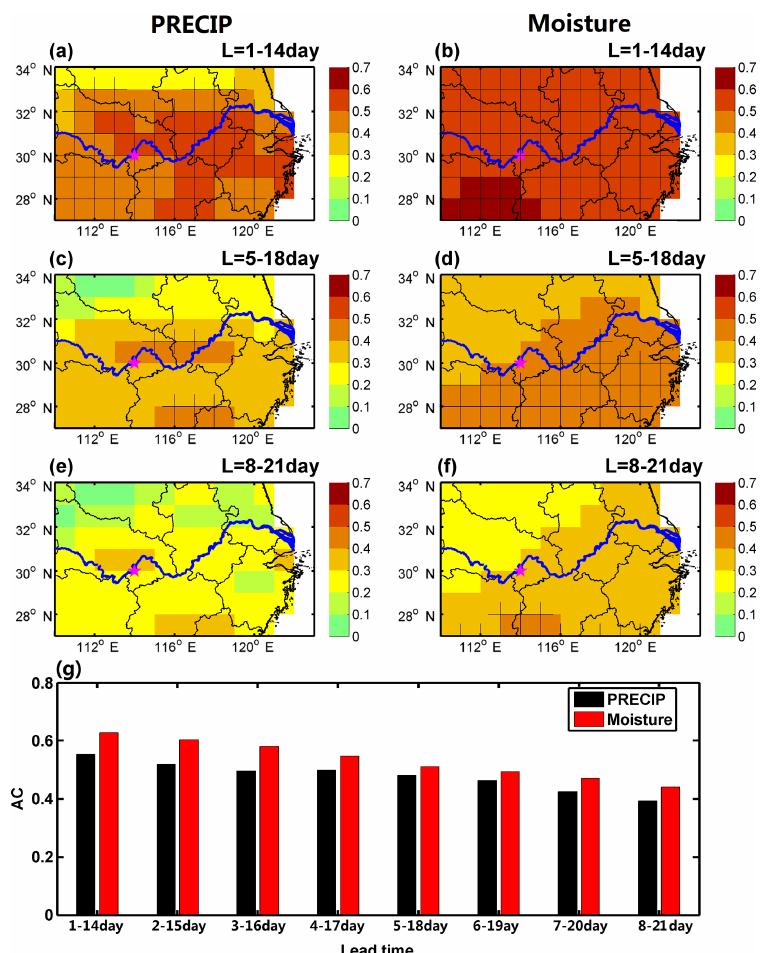
Figure 7. (a–f) Potential predictability (AC value) for weekly mean precipitation and atmospheric moisture flux at different lead times during June–July of 1999–2010 over the middle and lower reaches of the Yangtze River for the 1–14-, 5–18-, and 8–21-day leads; the stippling indicates a 95% confidence level according to a two-tailed Student’s t -test. (g) Potential predictability throughout the study region at different lead